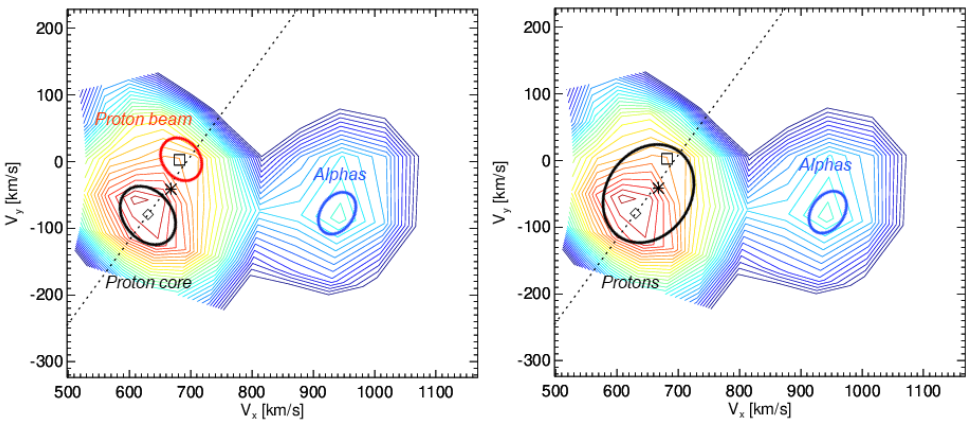
Figure 2. A demonstration of the proton beam effect on the temperature determination. The background isocontours are fit to ion energy distribution from Figure 1, the magnetic field direction is shown by the dotted line, the ellipses distinguish identified ion populations and their temperature anisotropy. The left-hand panel reflects proton core-beam structure, the right-hand panel treats all protons as one population. The parameters of the fit under one proton population are: N = 2.88 cm − 3 ; V = 638 km/s, V th (cid:107) = 56.18 km/s, V th ⊥ = 54.67